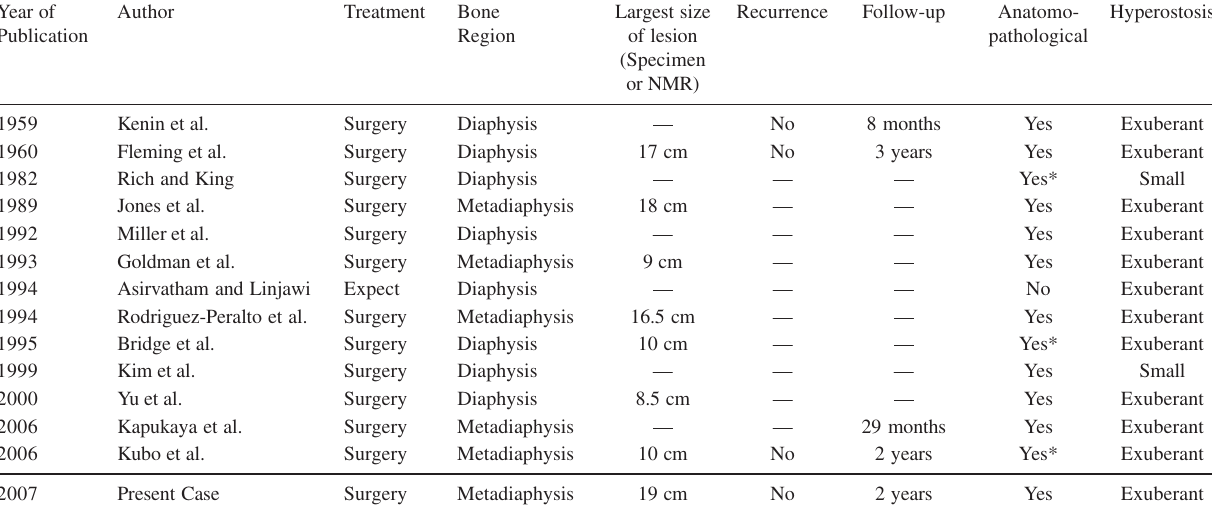
Table 1 B – Patients with parosteal lipoma of the femur with hyperostosis (identified in literature in English language) Year